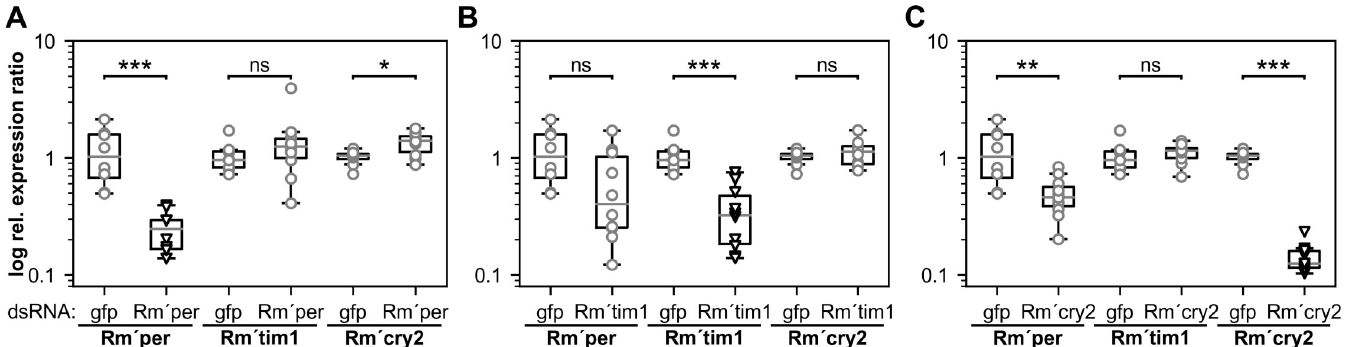
Fig 8. A-C. Quantitative PCR (qPCR) showed that Rm´per (A; n = 10), Rm´tim1 (B; n = 10), and Rm´cry2 (C; n = 11) dsRNA injection successfully downregulated mRNA levels of the respective gene (open triangles). The dsRNA experiments revealed only a significant interdependence of Rm´cry2 with Rm´per transcript levels, while Rm´tim1 was independent of both ( A-C ). Animals that were recorded before in the running wheel assays (Figs 1–6) were sacrificed about one month after injection of dsRNA and their mRNA levels were monitored using qPCR. Open circles and triangles indicate relative expression ratios of individual animals with respect to the mean value of gfp dsRNA injected animals (controls). Kruskal-Wallis tests were used to determine significant differences between gfp (n = 8) and Rm’per/Rm ´tim1 / Rm´cry2 dsRNA injected animals. ns: not significant; � : p < 0.05; �� : p < 0.01; ��� : p <